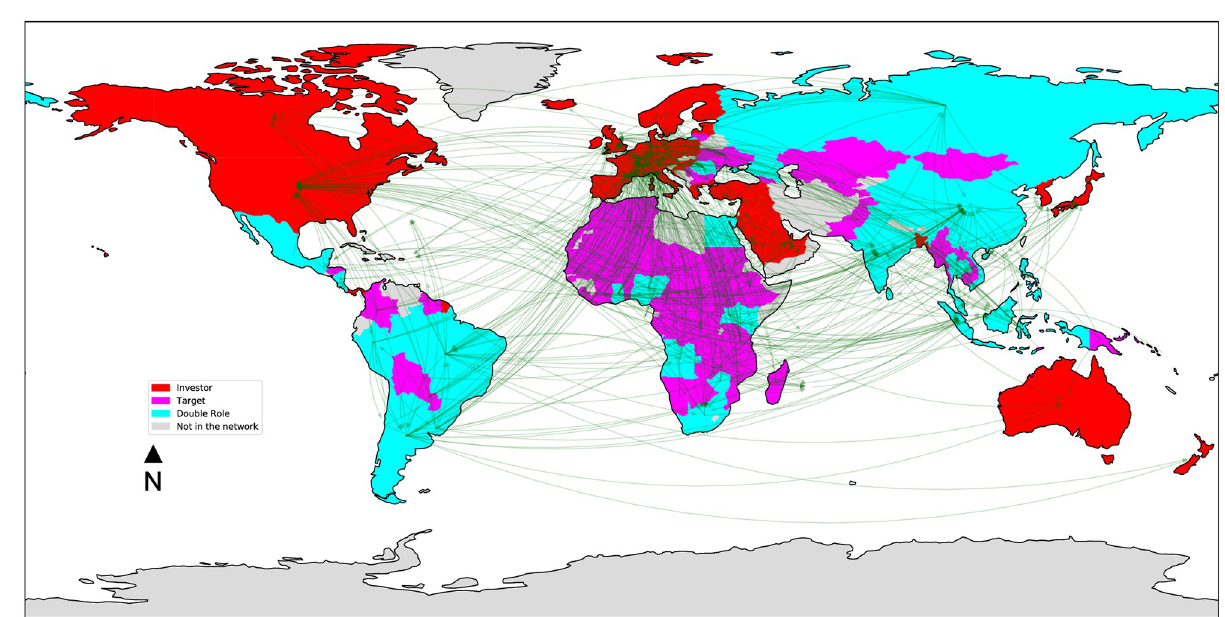
Fig 4. The agriculture land trade network, where countries are colored based on their role: Source nodes/pure investors (red), sink nodes/pure targets (magenta), double role countries (cyan). Countries colored in grey are absent from the network.